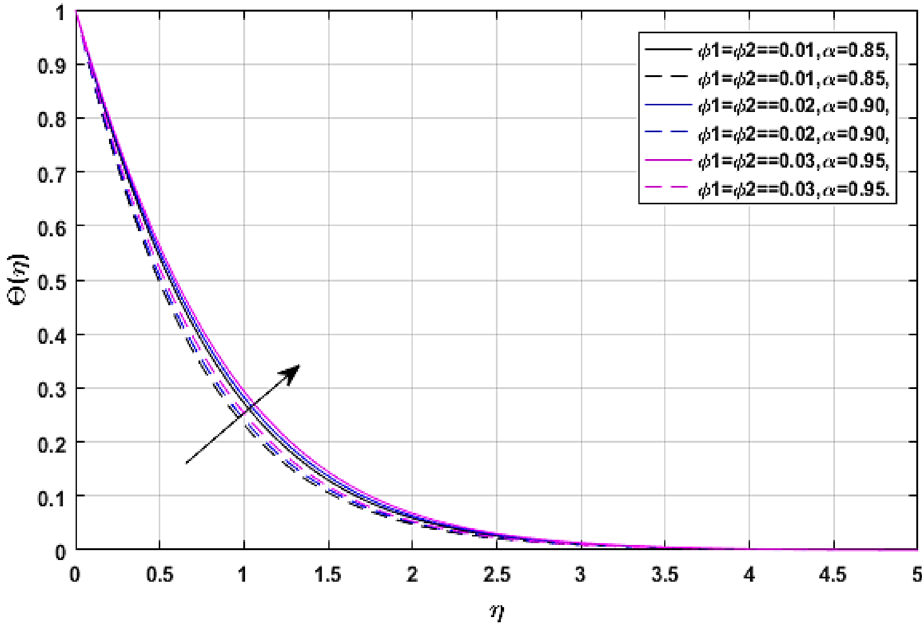
Figure 10. φ 1 , φ 2 versus temperature field when M = (cid:31) = E = Ec = 0.1, Pr = 21.